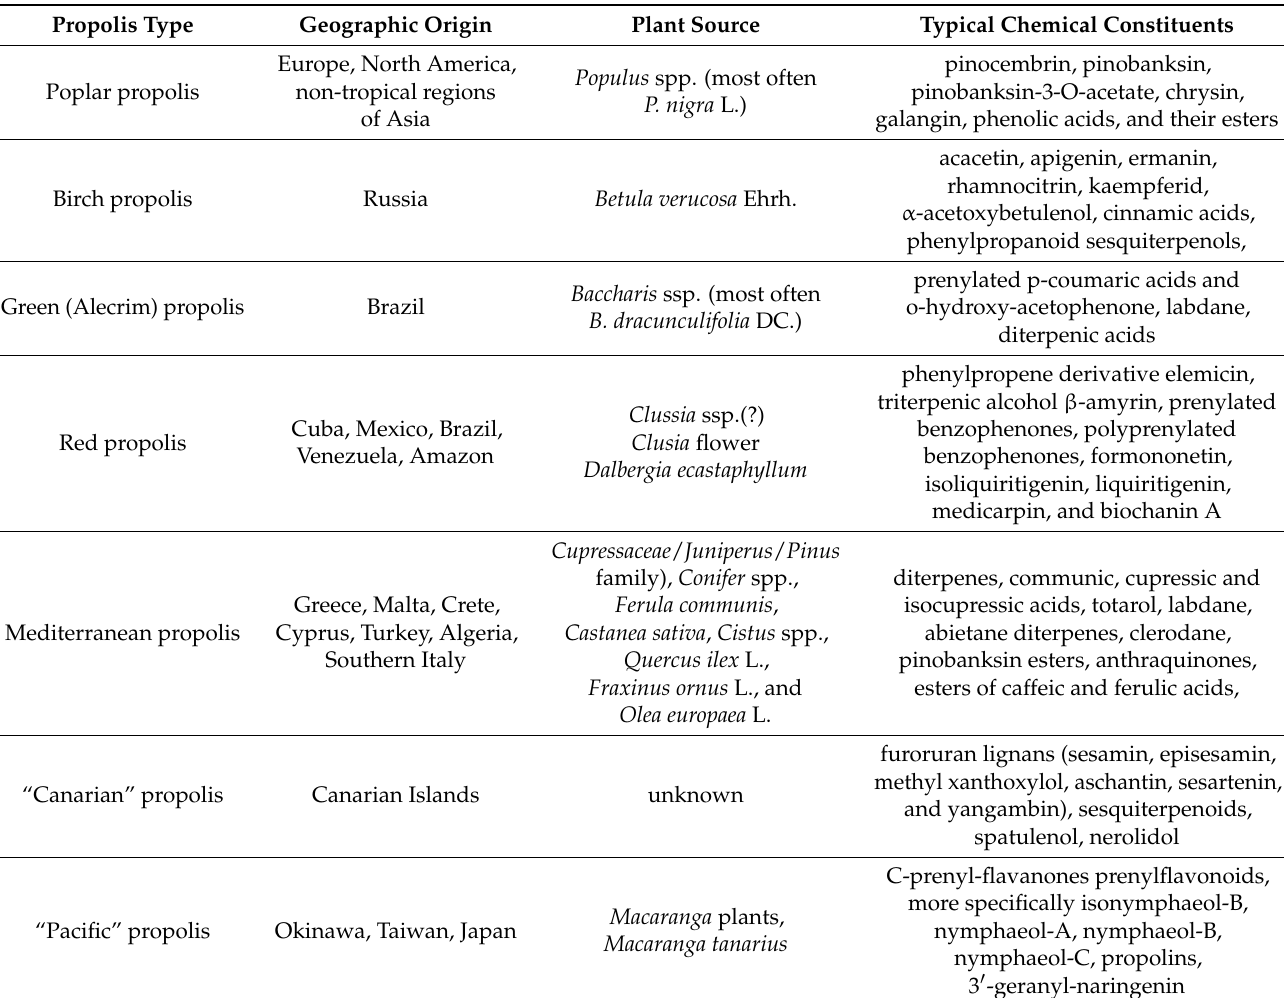
Table 1. The major types of propolis, their geographical origin, and major